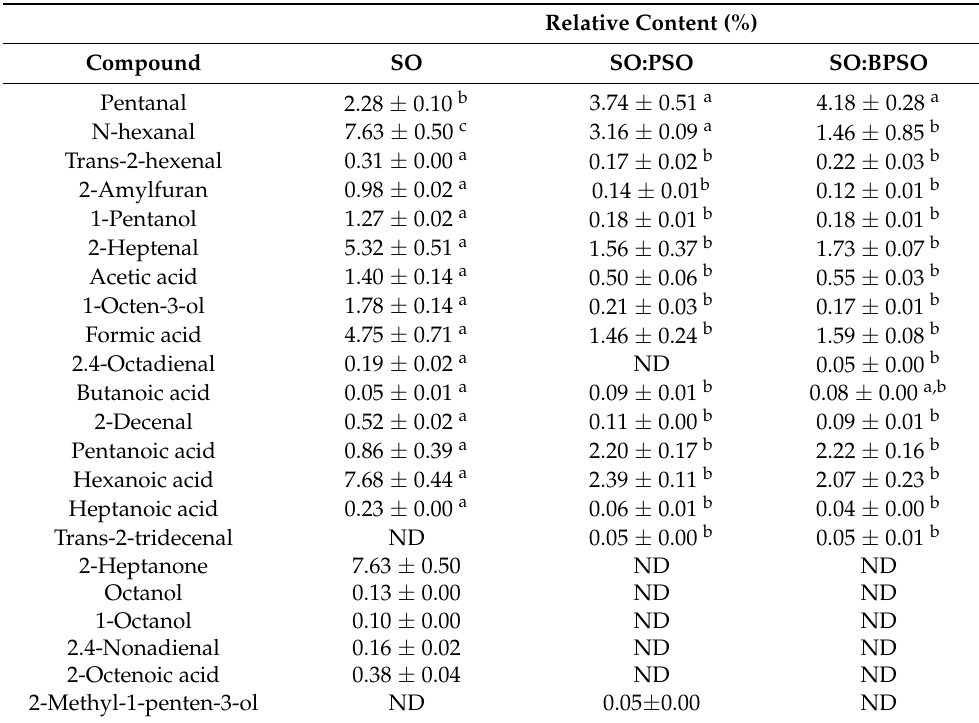
Table 4. Main volatile compounds identified in SO and oil blends (85:15 w / w ) at the end of the accelerated storage period (20